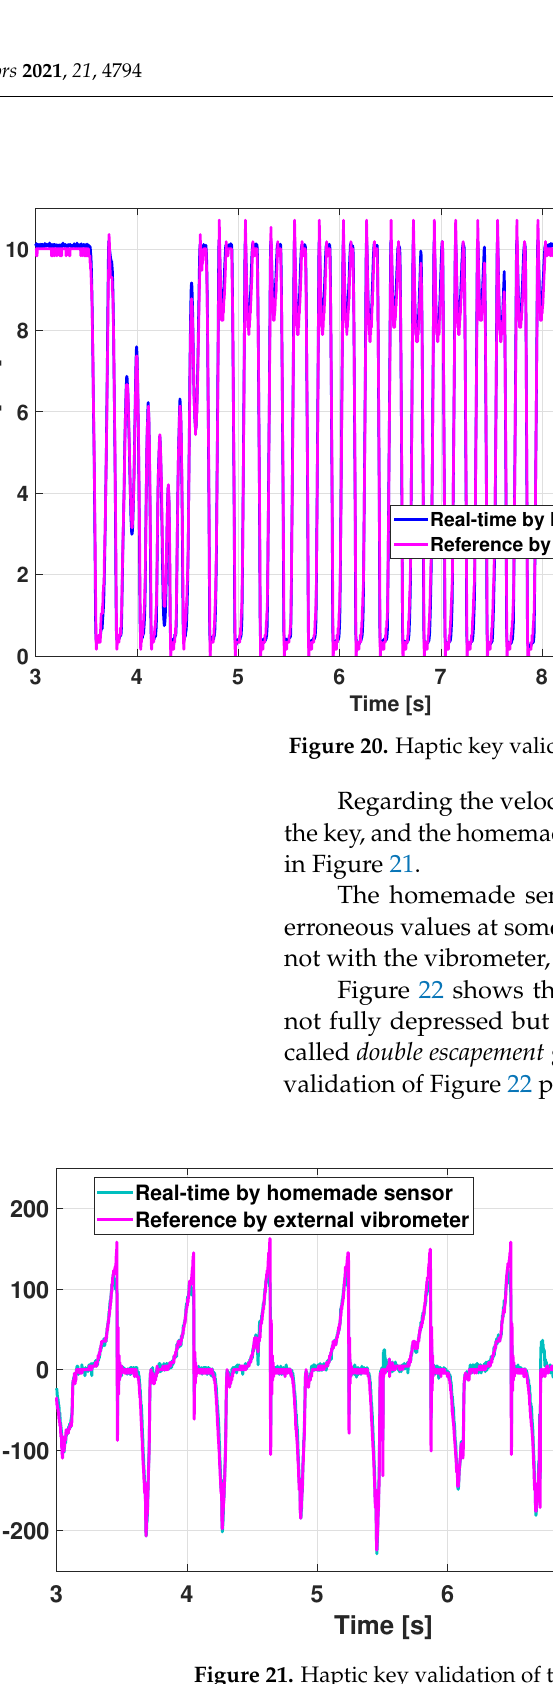
Figure 21. Haptic key validation of the velocity sensor: high amplitude, fast